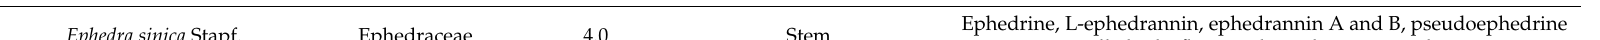
Pinellia ternata (Thunb.)